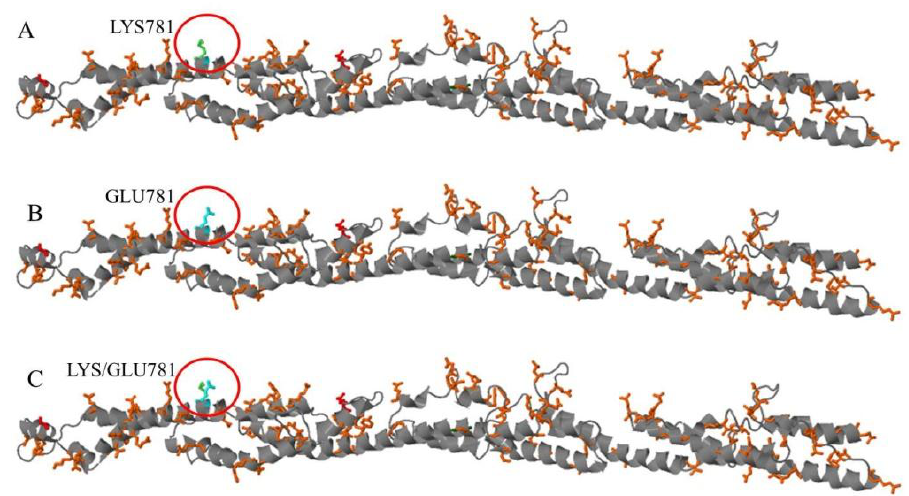
Figure 4. Image of the coiled coil region from amino acid 331 to amino acid 906 of the KIF5A protein and the spatial visualization of the wild-type and mutant amino acids at targeted position 781. ( A ) Spatial visualization of the Lysine at position 781; ( B ) Spatial visualization of the Glutamate at position 781; ( C ) Spatial visualization of both the Lysine and the Glutamate at position 781.